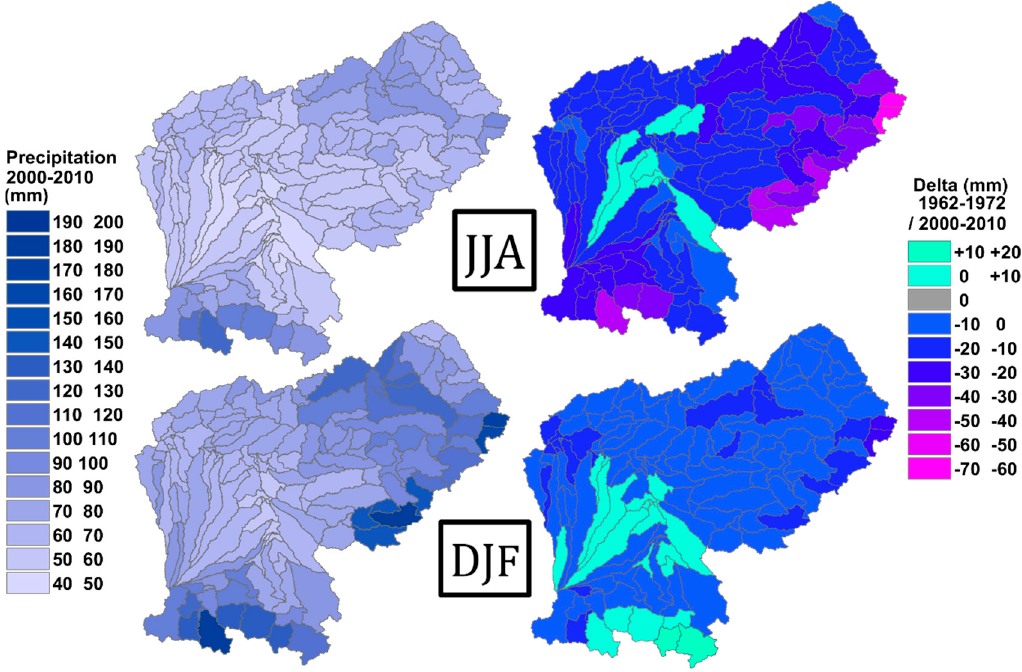
Figure 5. Total Precipitation during the 2000–2010 decade and variations with the 1962–1972 decade (seasonal mean monthly values).